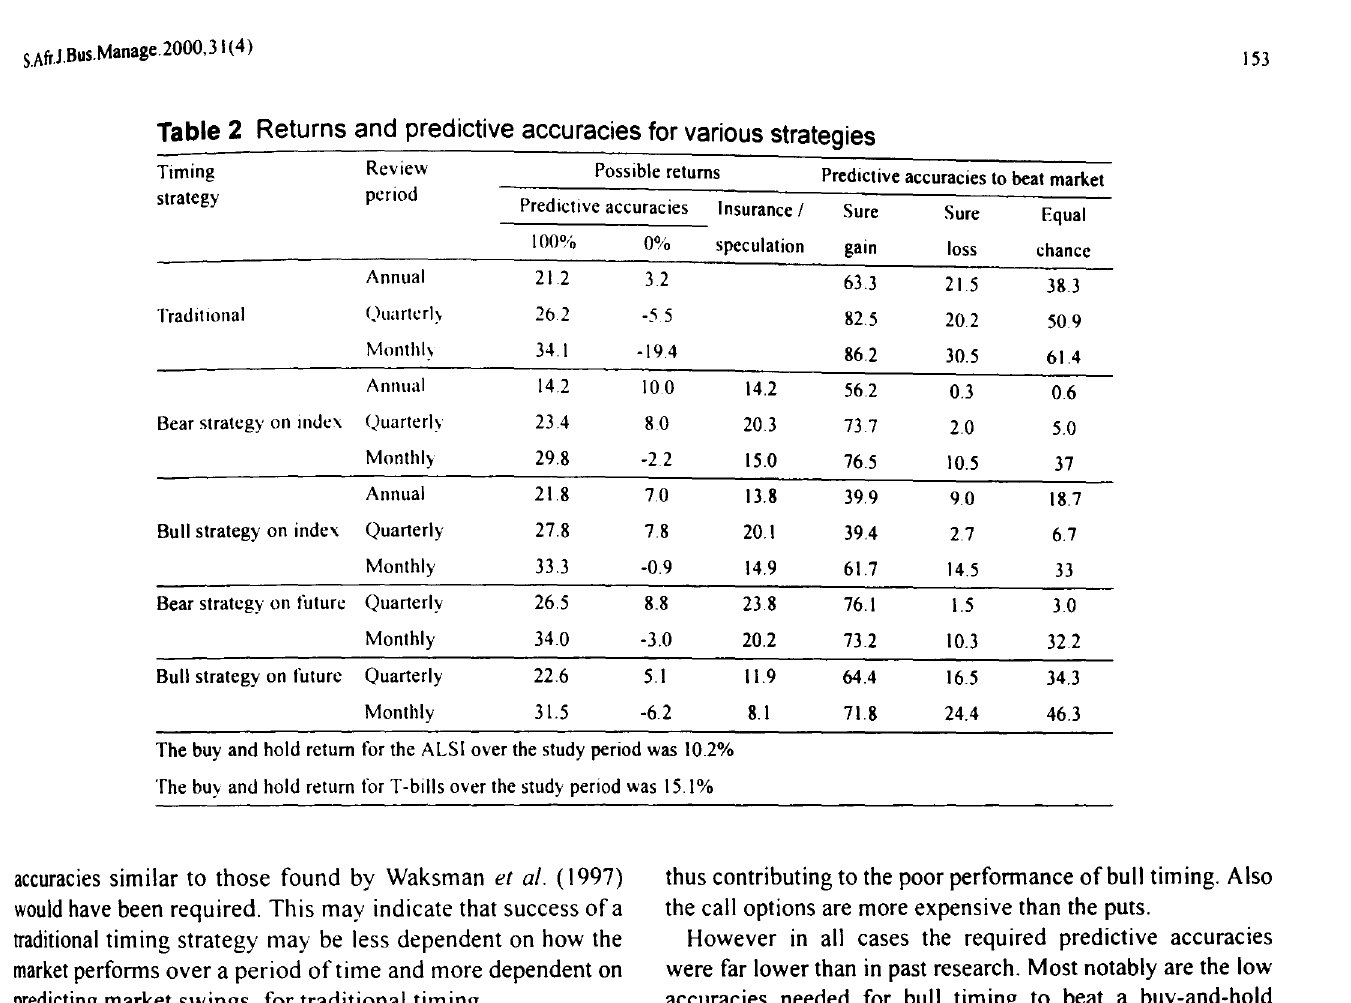
Table 2 Returns and predictive accuracies for various strategies Timing Review Possible returns Predictive accuracies to beat market strategy period Predictive accuracies Insurance I Sure Sure Equal 100% 0% speculation gain chance